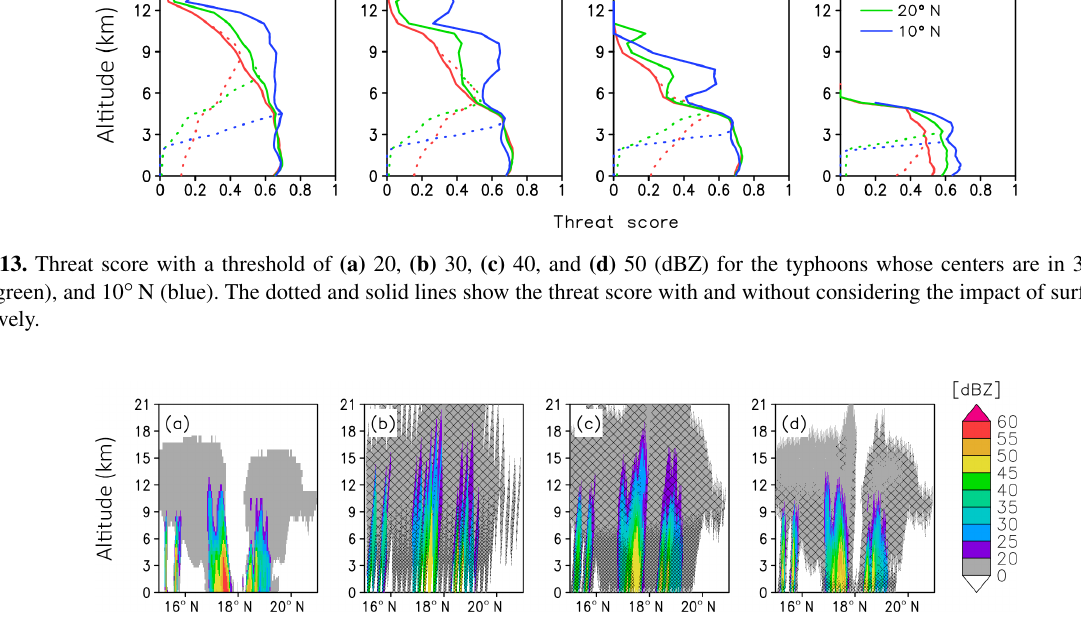
Figure 14. Precipitation reflectivity (dBZ) along the 136.4 ◦ E longitude line passing through the typhoon center in the mature stage (00:00UTC, 5 August 2015) for (a) the truth, (b) bw20bs20, (c) bw20bs05, and (d) bw05bs05. The areas where reflectivity from pre- cipitation<0dBZ are left blank, and the area affected (SCR<0) by mainlobe (sidelobe) clutter is densely (sparsely) hatched in ( b )–( d ).